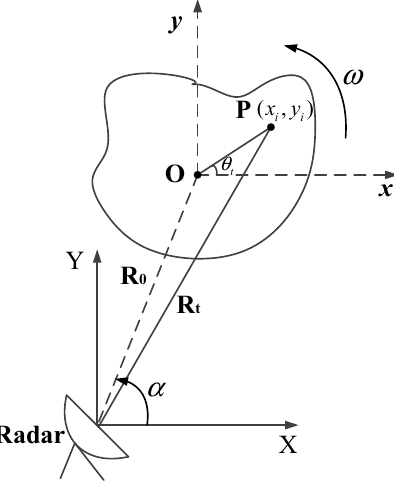
Figure 1. ISAR imaging geometry.